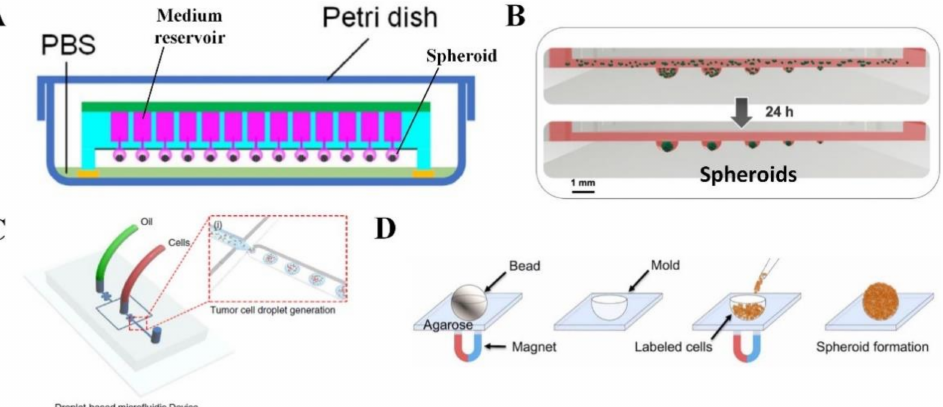
Figure 2. Tumor spheroids. ( A ) A device that allows long-term culture of hanging drop tumor spheroids. Adapted with permission from [30] © Elsevier (2021). ( B ) A multisize hanging drop tumor spheroid array. Adapted with permission from [32] © Creative Commons Attribution License (2021). ( C ) A microfluidic device that traps tumor cells in droplets for formation of tumor spheroids with uniform cell distribution. Adapted with permission from [33] © Creative Commons Attribution License (2021). ( D ) Tumor spheroid formation induced through magnetic levitation. Adapted